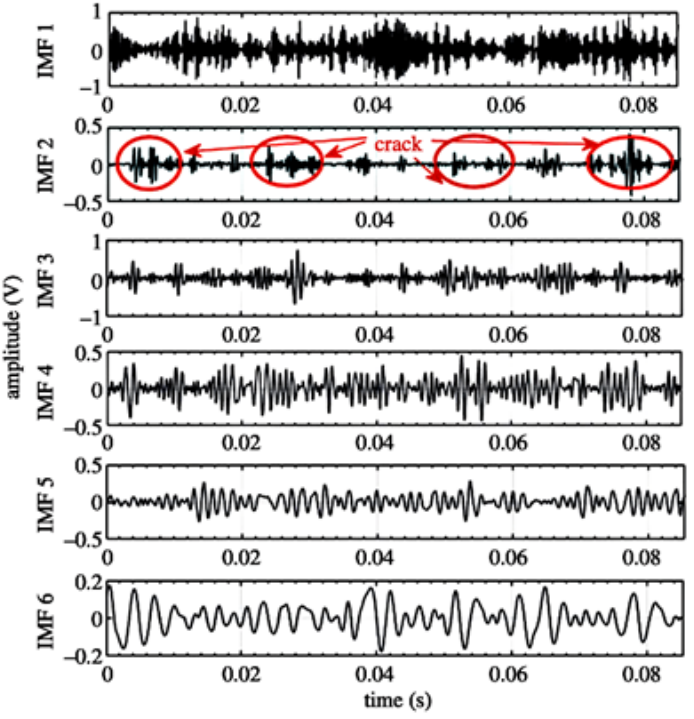
Figure 17. Fault detection using CEEMDAN method